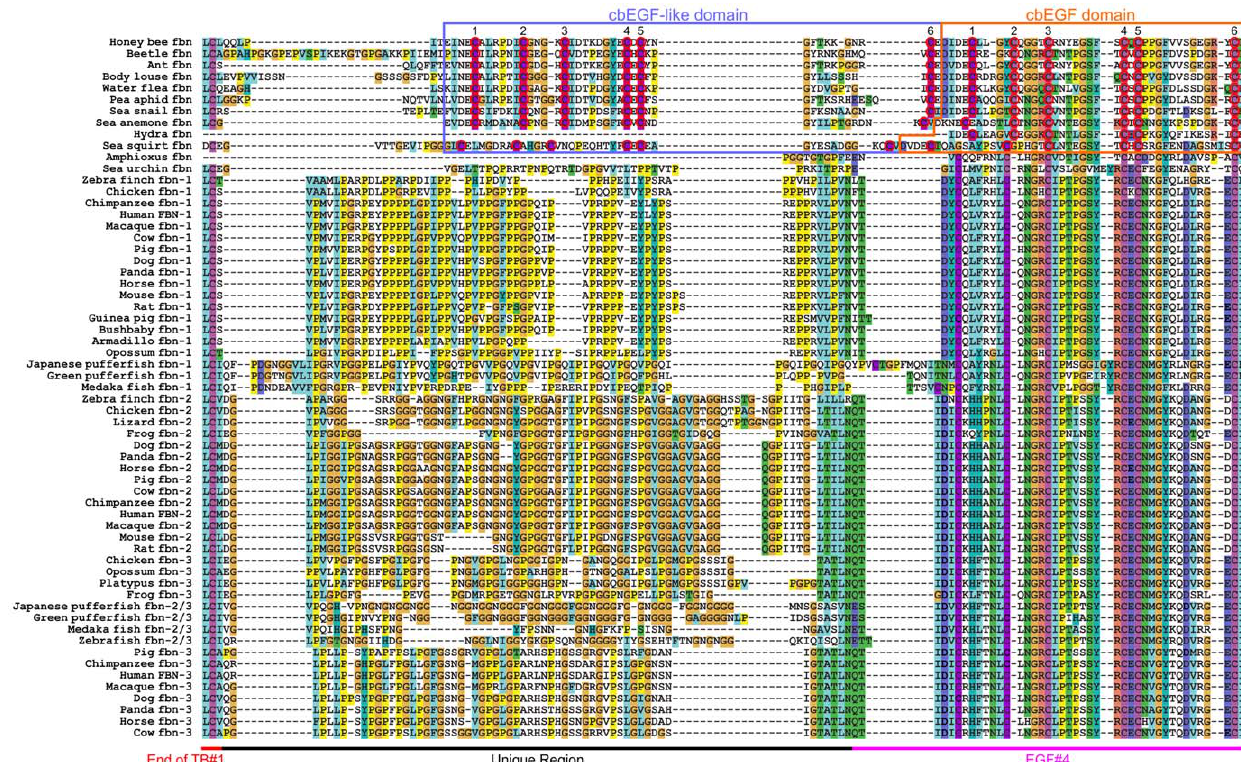
Figure 4. Excerpt from the ClustalX alignment of full length fibrillin focusing on the unique regions and the subsequent EGF4 domain. The end of TB1, the unique region, and the EGF4 domain found characteristically in mammalian fibrillins are indicated on the bottom. For invertebrate organisms, the cbEGF-like (purple box), and the new cbEGF domain (orange box) are highlighted, and cysteine residues are circled in red in these domains. The relative numbers of the cysteine residues within the respective EGF domain is indicated on top. Note that the unique region does not exist in invertebrate fibrillin proteins, and is instead replaced by a cbEGF-like domain. The non-calcium binding EGF4 domain that typically follows the unique region is replaced in invertebrate fibrillins by a cbEGF